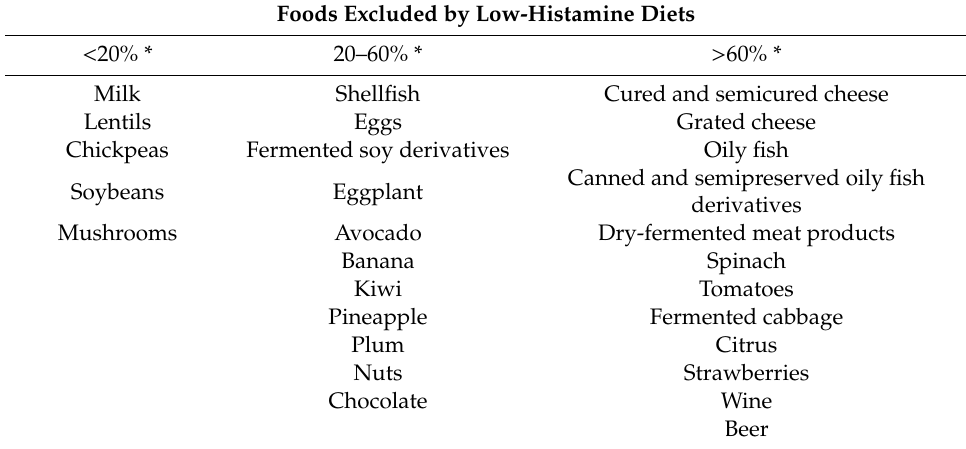
Table 3. Foods excluded in the di ff erent low-histamine diets found in the literature [10,87,91,112–118]. Foods Excluded by Low-Histamine Diets < 20% * 20–60% * > 60% * Milk Shellfish Cured and semicured cheese Lentils Eggs Grated cheese Chickpeas Fermented soy derivatives Oily fish Canned and semipreserved oily fish Soybeans Eggplant derivatives Mushrooms Avocado Dry-fermented meat products Banana Spinach Kiwi Tomatoes Pineapple Fermented cabbage Plum Citrus Nuts Strawberries Chocolate Wine